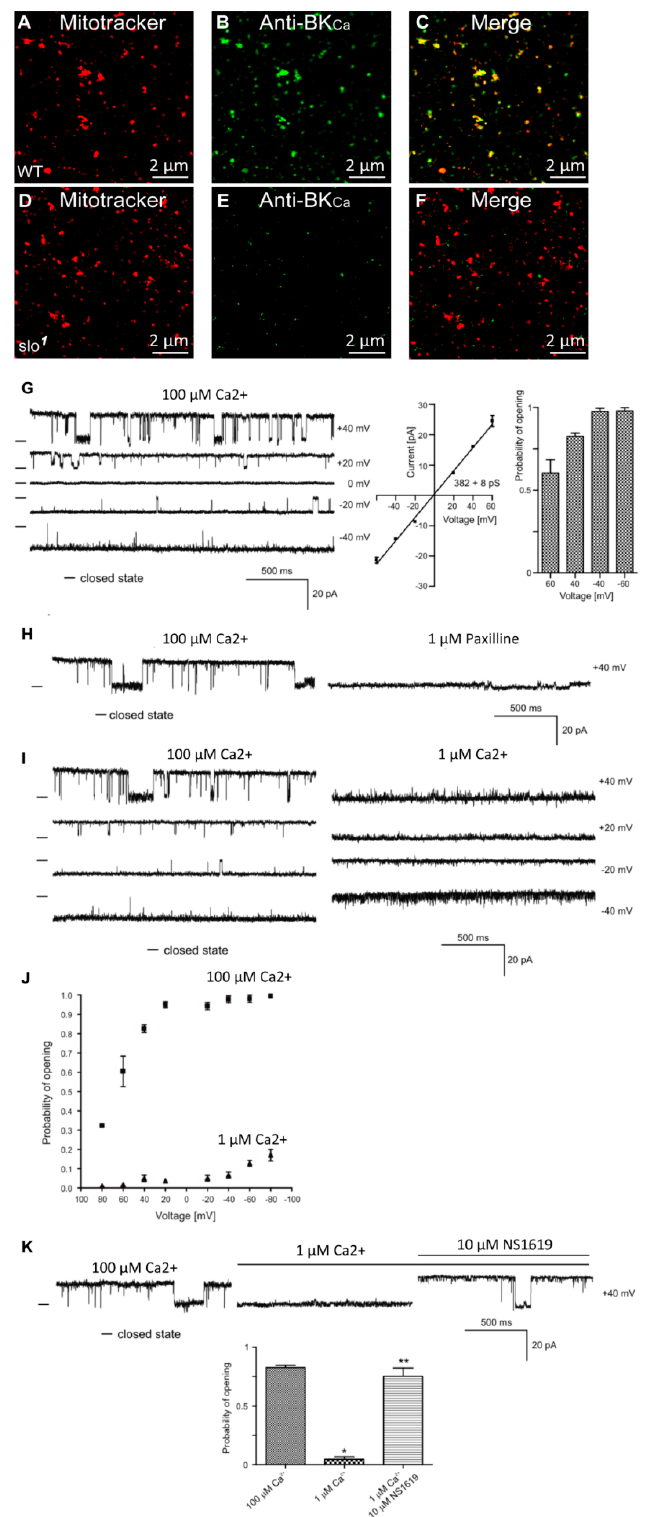
Figure 1. Localization of dSlo in isolated mitochondria. High-resolution confocal images of isolated mitochondria from Drosophila ( A – C , wild type, D – F slo mutants) loaded with mitotracker ( A , D red) and labeled with an anti-Slo antibody ( B , E green). Overlays are shown in ( C , F ). Protein proximity index for dSlo to mitotracker was 0.5 ±